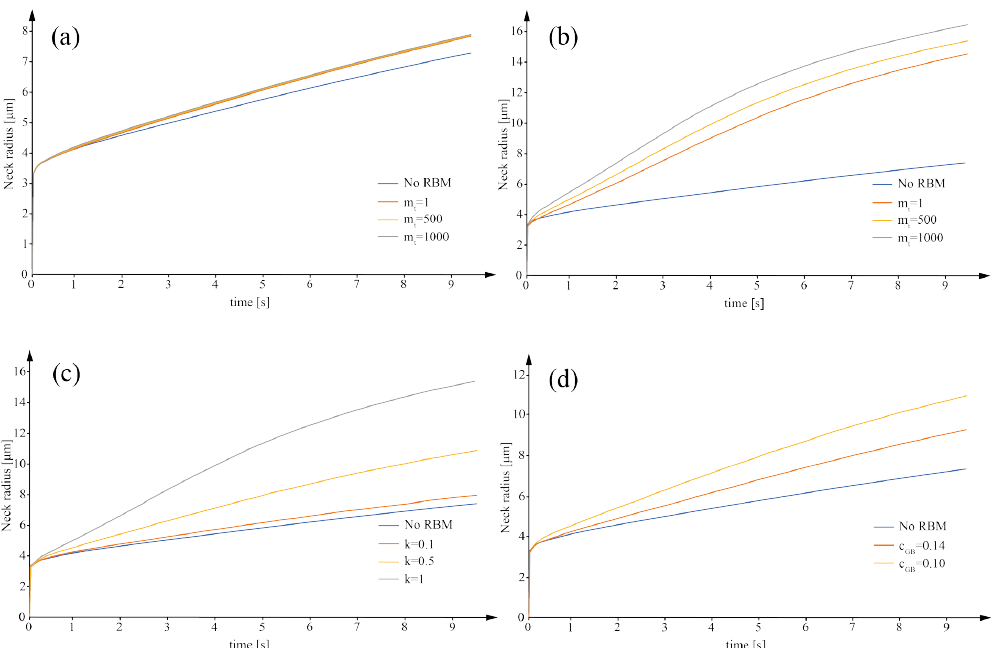
Figure 4. ( a ) Effect of the mobility translation (m t ) for k = 0.1 and c GB = 0.1; ( b ) effect of mobility translation (m t ) for k = 1 and c GB = 0.1; ( c ) effect of stiffness constant (k) for m t = 500 and c GB = 0.1; and ( d ) effect of the concentration threshold (c GB ) for k = 0.5 and m t = 500.